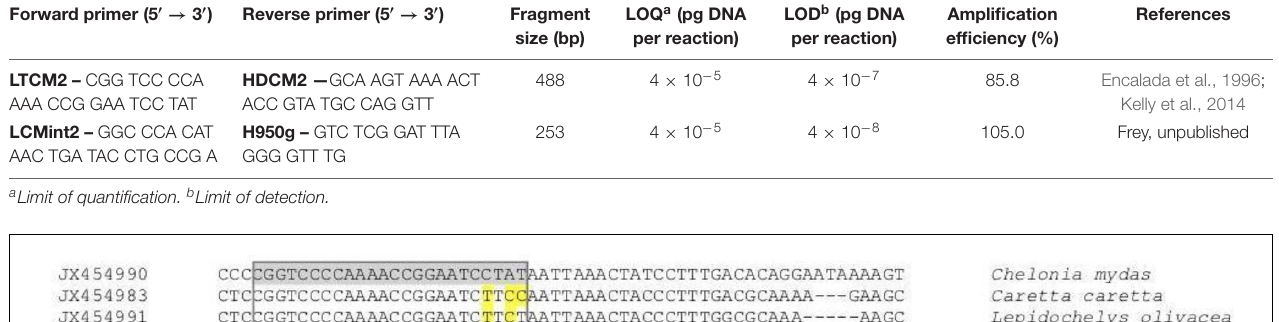
(LOQ) were estimated using a 10-fold serial dilution of